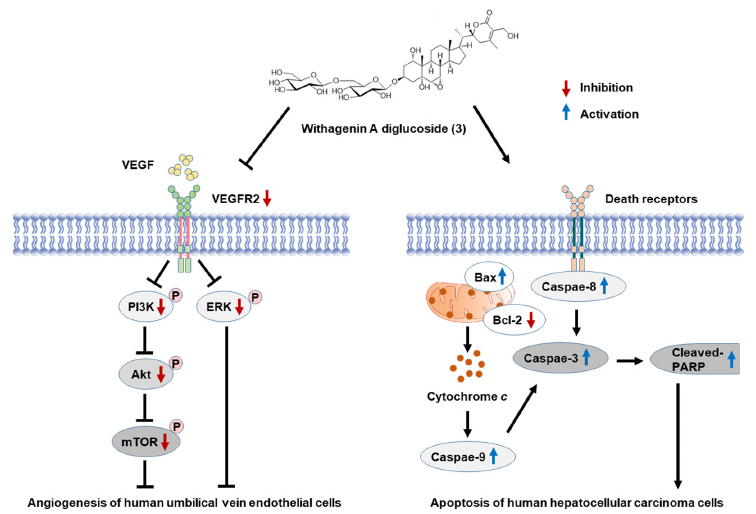
Figure 11. Schematic pathway illustrating the potential role of withagenin A diglucoside (WAD) on apoptosis of human hepatocellular carcinoma cells and tube formation in human umbilical vein endothelial cells. VEGFR2, vascular endothelial growth factor receptor 2.